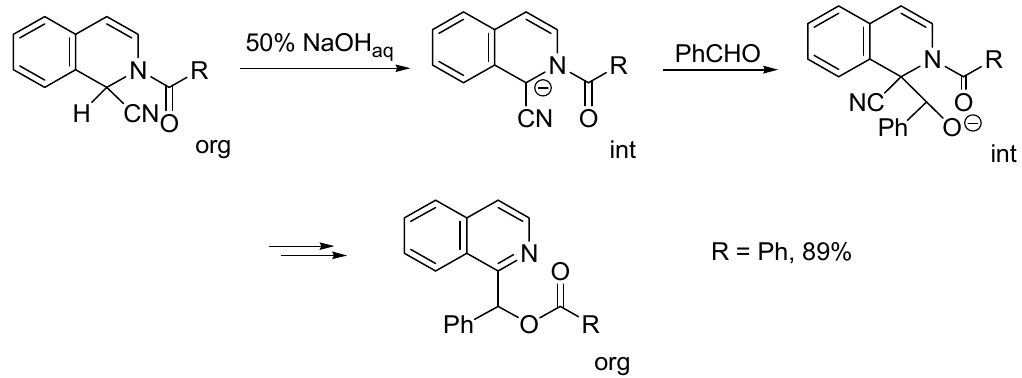
Scheme 7. Interfacial reaction of the Reissert compound with aldehydes in the presence of aqueous NaOH.